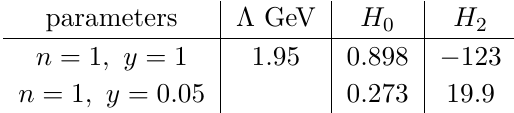
Figure 7 . The real and imaginary parts of the particle-dimer phase shift at different orders of EFT. The values of parameters are Λ = 1 . 95 GeV and y = 0 . 05 . The number of subtractions (whenever needed) is chosen to be equal to one.